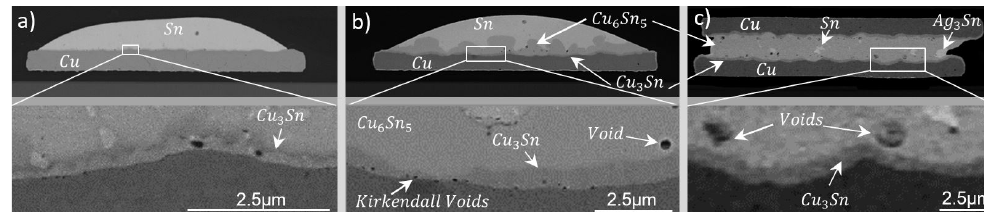
Figure 9. Cu80 sample with a 40µm solder ball on a 80µm pad after bumping ( a ) and ball reflow; ( b ) full IMC joint after tacking and module reflow ( c ). The second row presents a zoomed view of the marked rectangular area at the pad interface.